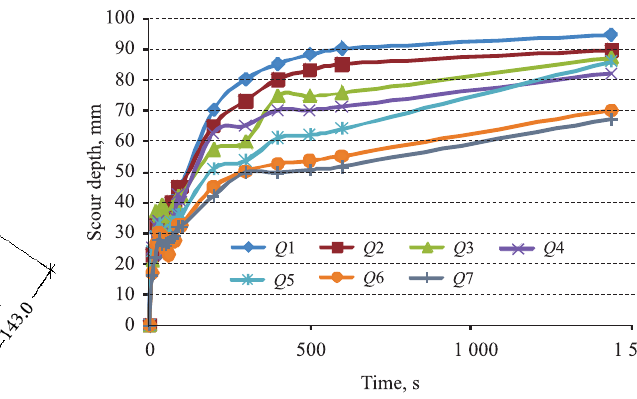
Fig. 9. Wheel loads applied at quarter-span (in mm) Fig. 10. The effect of fast velocity on the scour depth in Q side with time, vehicle located at